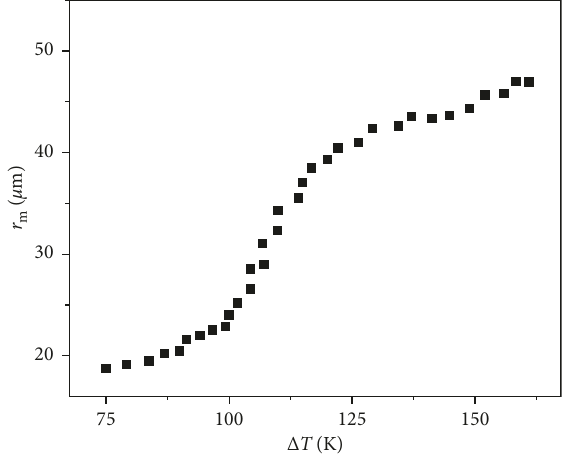
Figure 6: Relationship between the undercooling ∆ T and the maximum radius r m of Fe-rich droplets in the Cu-15 wt.% Fe